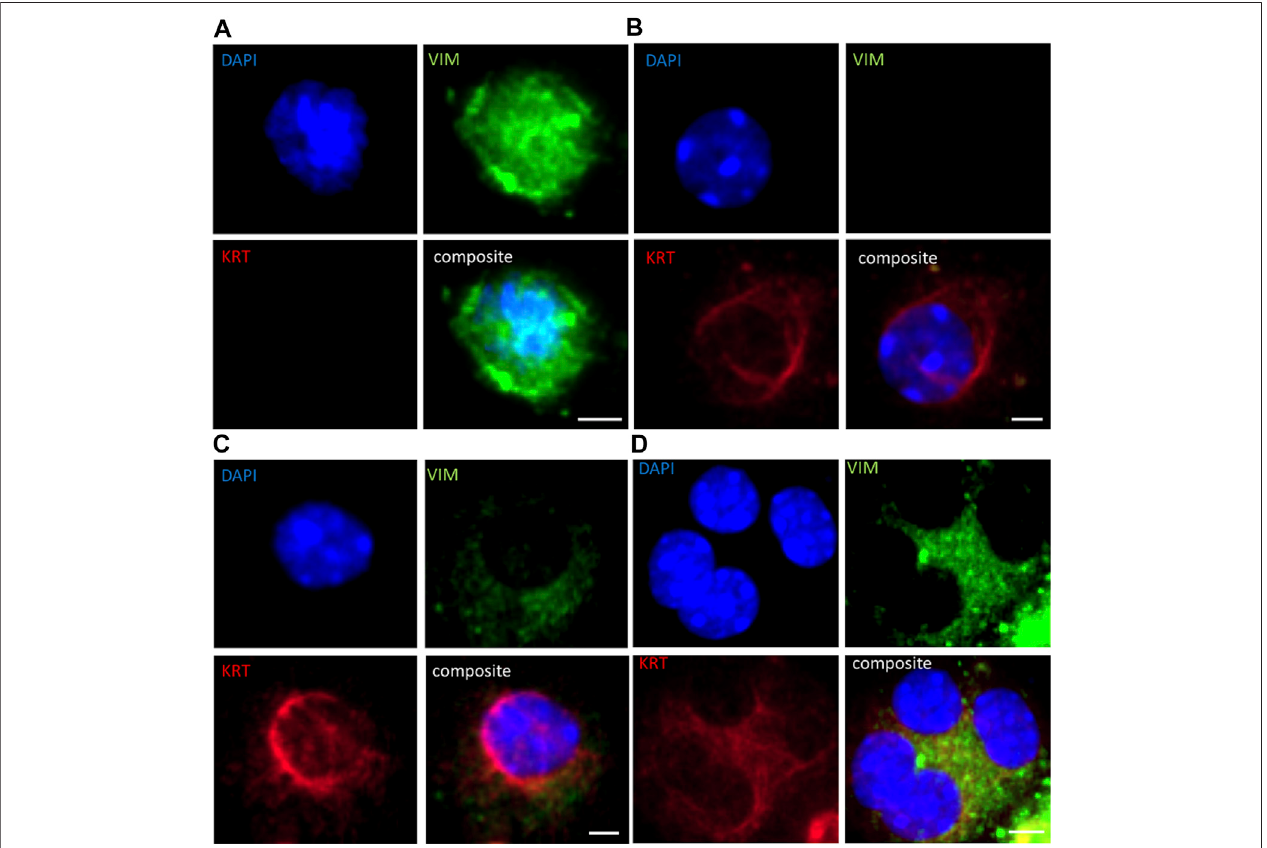
FIGURE 2 | Immuno fl uorescence staining for (A) vimentin (VIM; green) only, (B) epithelial cytokeratins (KRT; cytokeratins 8/18/19; red) only, (C) hybrid cells (both VIM and KRT; orange), and (D) cluster of hybrid cells in PDX-derived CTCs in a representative blood sample from a castrated LuCaP96 xenograft mouse. Scale bar denotes 5 µm.